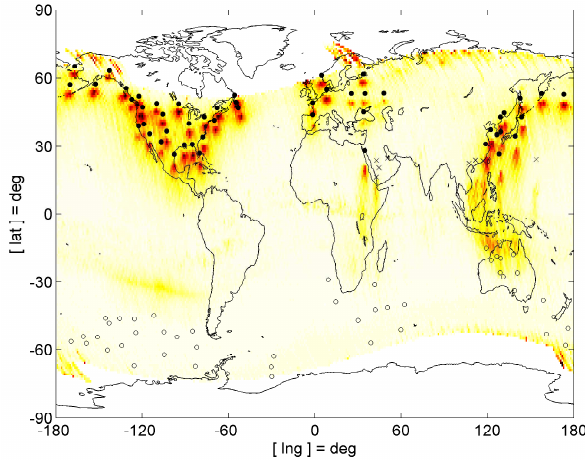
Fig. 1. Fifty Long Range Aid to Navigation (LORAN) transmit- ters (dots) emit 100kHz radio waves which illuminate the plasmas- phere with luminosity patches (red blobs) as inferred from electric field measurements on board the DEMETER satellite at ∼ 660km height above the ground. The luminosity patches exhibit a ∼ 450km southward displacement with respect to the locations of the LORAN transmitters. Eight LORAN transmitters at low latitudes < 25 ◦ (crosses) do not show a clear correspondence to any luminosity patch. The geomagnetic conjugate locations of the LORAN trans- mitters (circles) show that some transmitters in East Asia exhibit a diffuse luminosity northward of their conjugate location in Aus- tralia and Southeast